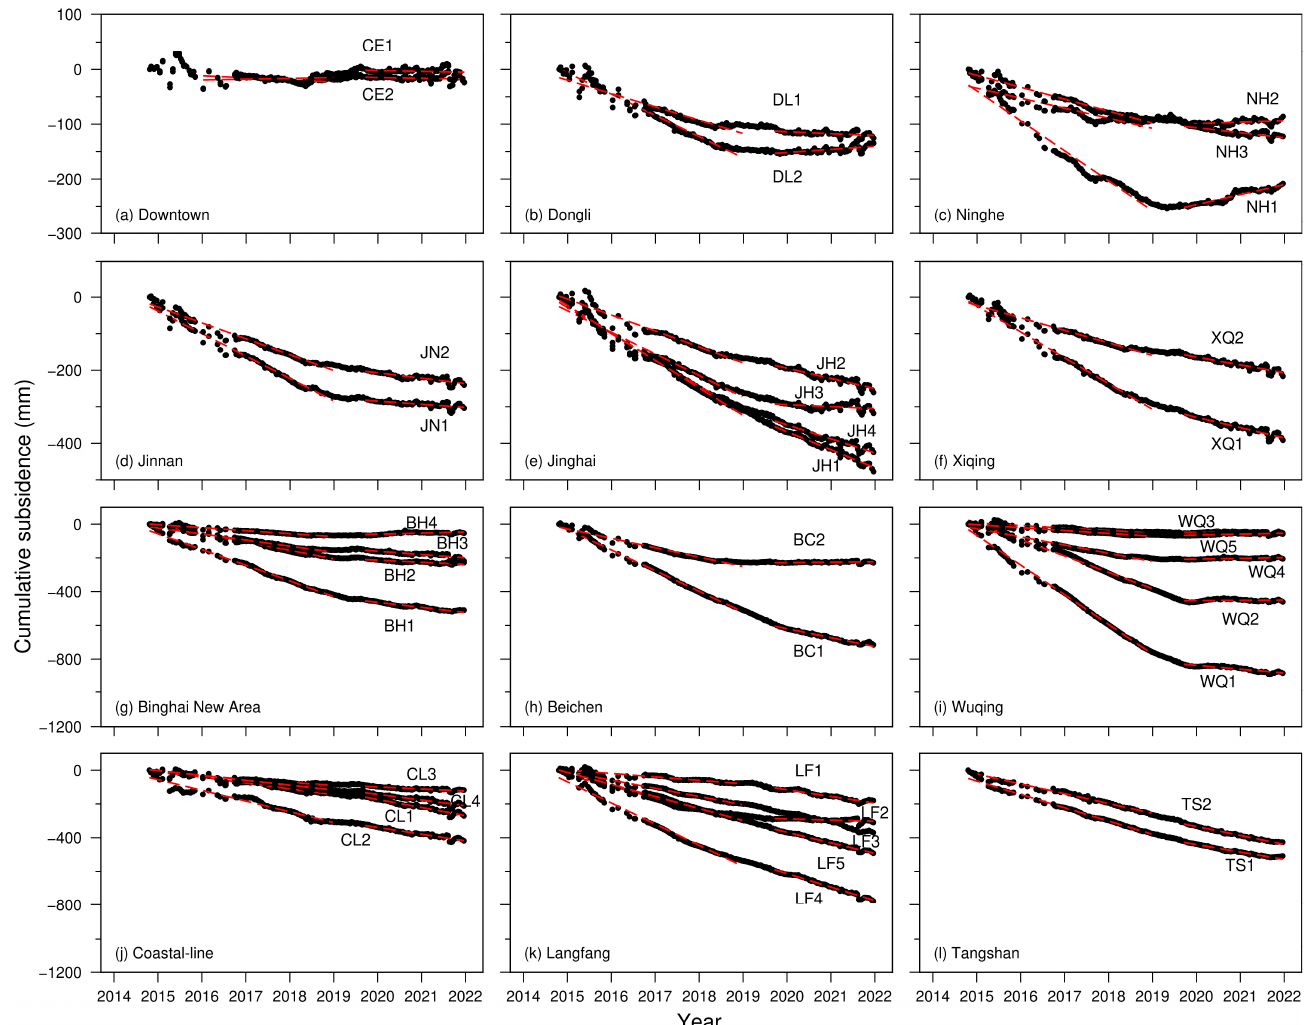
Figure 9. InSAR-derived subsidence time series in Tianjin and its adjacent areas. The locations of these points are marked in Figure 7. The red dashed lines indicate the linear trends before and after 2019.